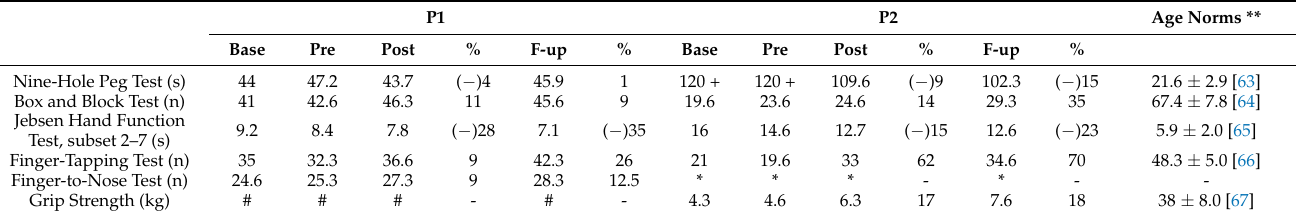
Table 2. Descriptive data from clinical